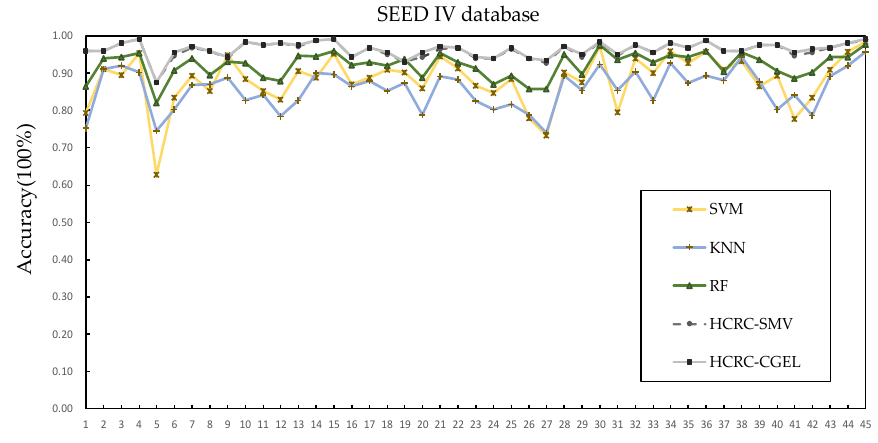
Figure 8. Results of each method on SEED IV database.